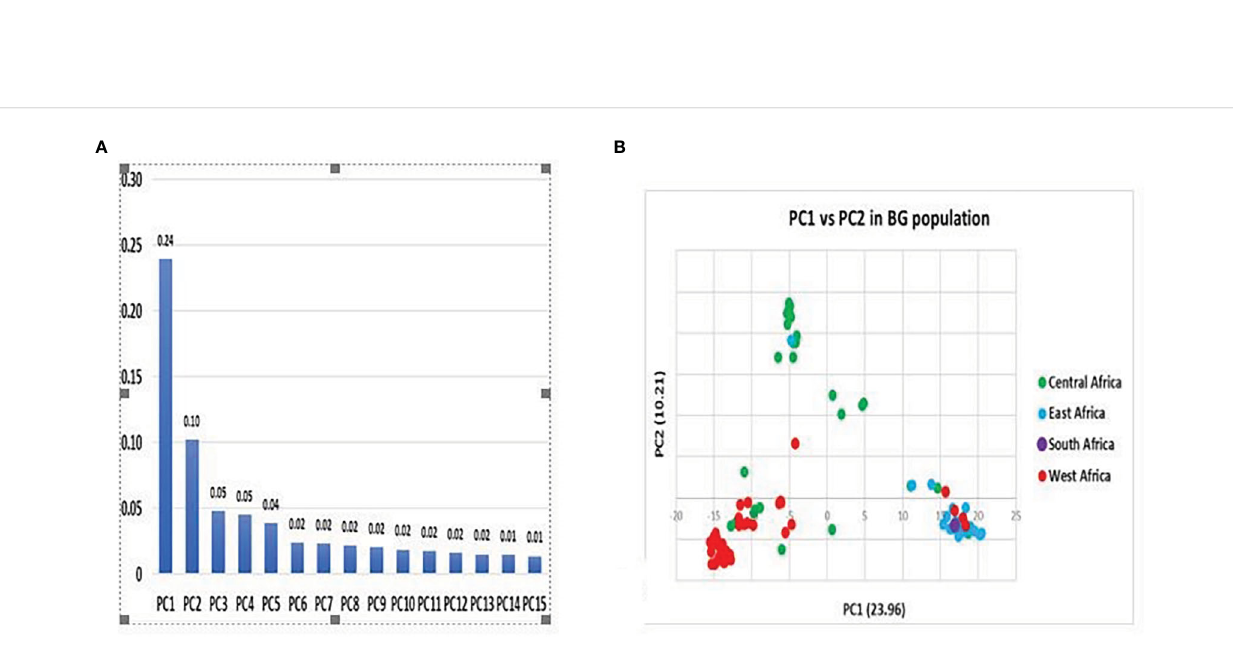
FIGURE 4 (A) Principal component contribution and (B) Principal coordinate analysis of total variation of Bambara accessions population based on